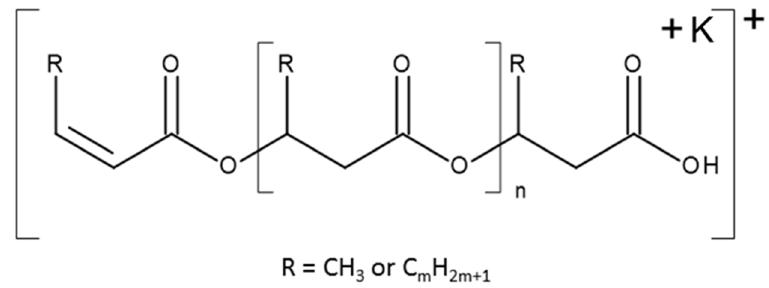
Figure 11. ESI-MS/MS spectrum obtained for the selected potassium adduct ion of the oligomers, [HB 5 HV + K] + , at m/z 569.